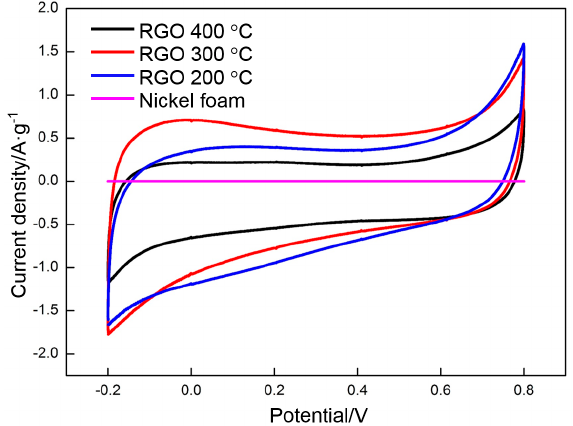
Figure 9. CV curves of nickel foam and RGO reduced at different temperatures.